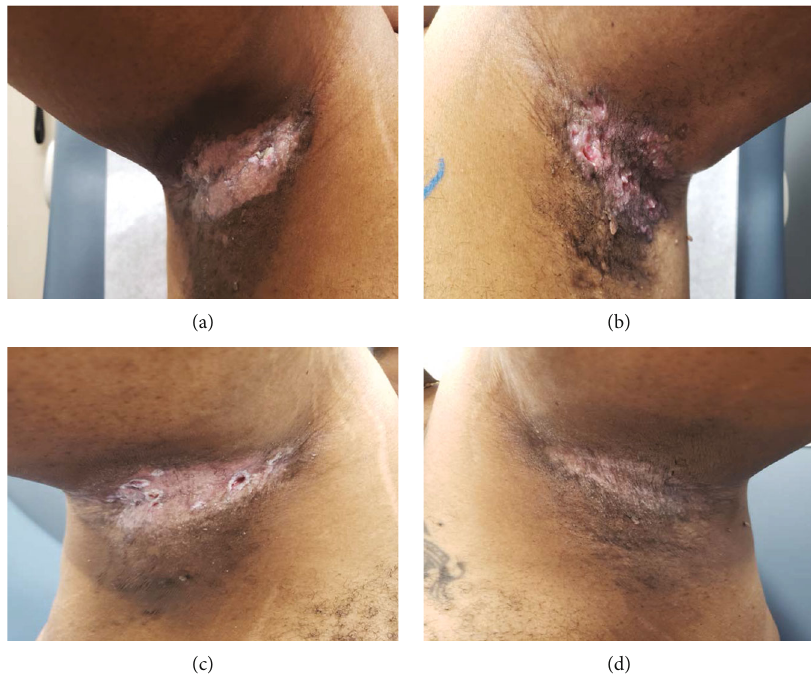
Figure 3: (a) Right axillary lesions 3 weeks after RT (8 Gy in 1 fraction). (b) Left axillary lesions prior to RT. Clinical response following RT for the right axilla (5-month posttreatment) (c) and left axilla (4-month posttreatment)